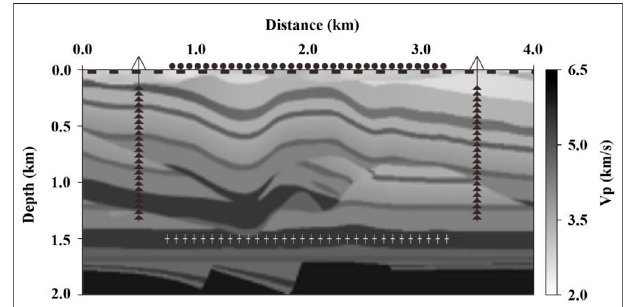
FIGURE1| Overthrustmodelwithconcealedstructures.Theblacksolid lines are the trajectories of the vertical observation wells and horizontal wells. The solid black circles at the top of the model represent the surface seismic sources. The black dashed line represents the receivers. The black trianglesrepresentthereceiversinthetwowellslocatedat x =0.5and3.5 km, respectively. The white cross symbols represent the perforations in the horizontal well which is located at the depth of z = 1.5 km. These form an acquisition system covering the complex fold structures with faults in the